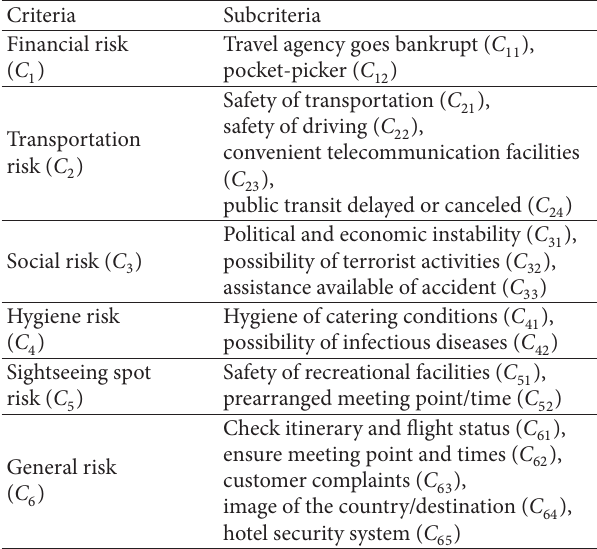
Table 1: Proposed criterion and their related